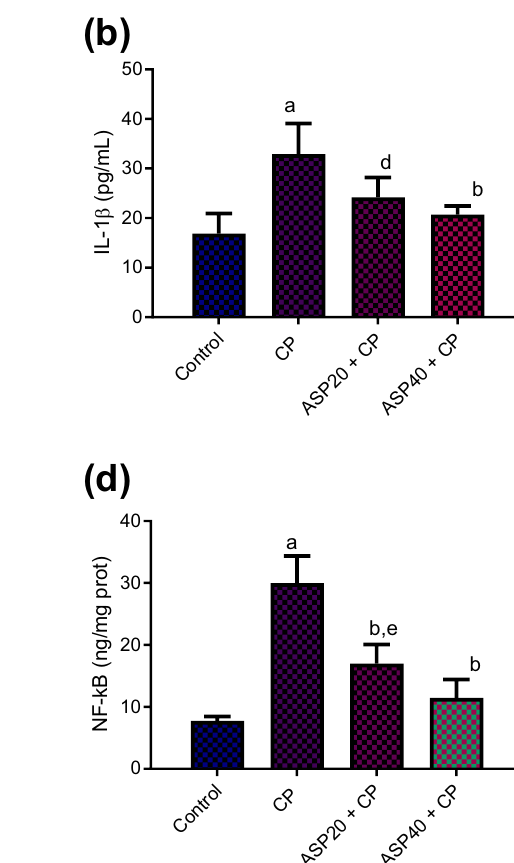
Figure 1: E ff ect of ASP on proin fl ammatory mediators in the bladder homogenates of CP treated rats. Data were analysed by one - way ANOVA followed by Tukey post hoc test using GraphPad Prism. ( a ) signi fi cantly di ff erent from control group at P < 0.001; ( b ) signi fi cantly di ff erent from CP group at P < 0.001; ( c ) signi fi cantly di ff erent from CP group at P < 0.01; ( d ) signi fi cantly di ff erent from CP group at P < 0.05; ( e ) signi fi cantly di ff erent from ASP40 + CP group at P <